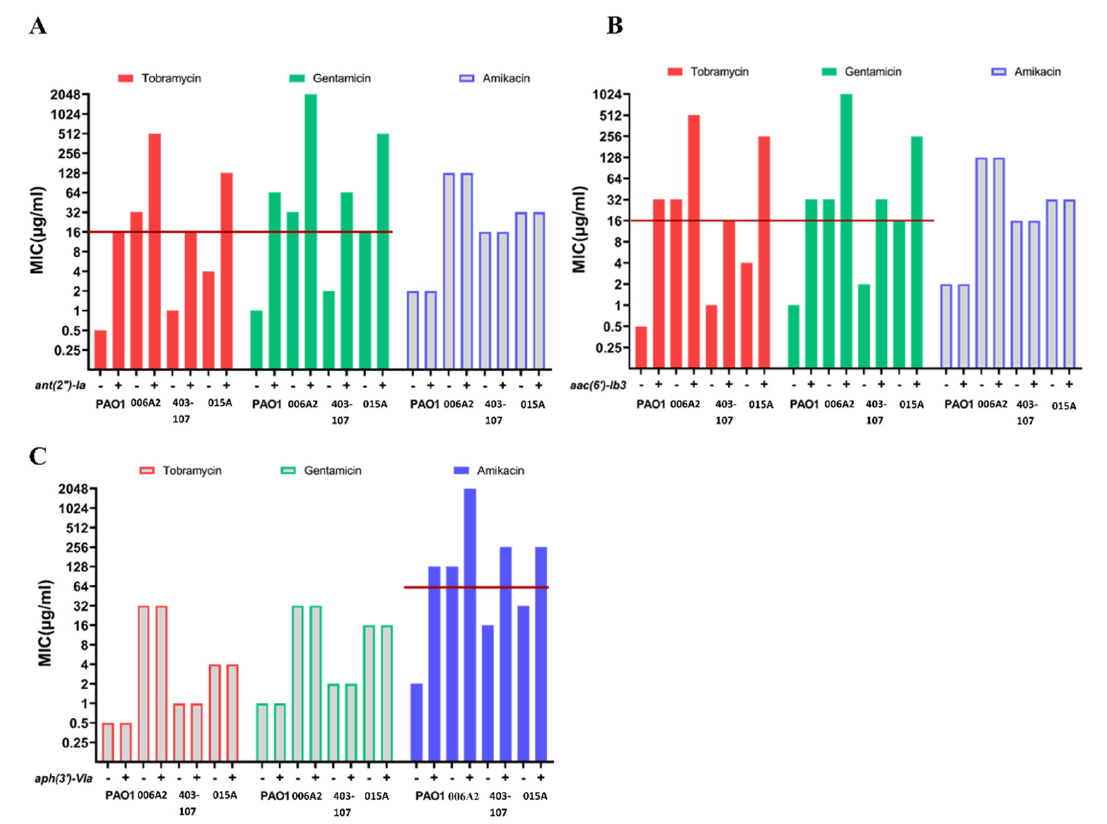
Figure 4. The effects of introduced AMEs on MICs. ( A ) ant (2 ″ )-Ia . ( B ) aac (6 ′ )-Ib3. ( C ) aph (3 ′ )-VIa . The cloned genes (represented as “+”) were expressed from cloning vector pSW196 in P. aeruginosa strains PAO1, 006A2, 403-107 and 015A. The vector-free parental strains are represented as “ − ”. CLSI clinical breakpoints for MICs are indicated by red lines.